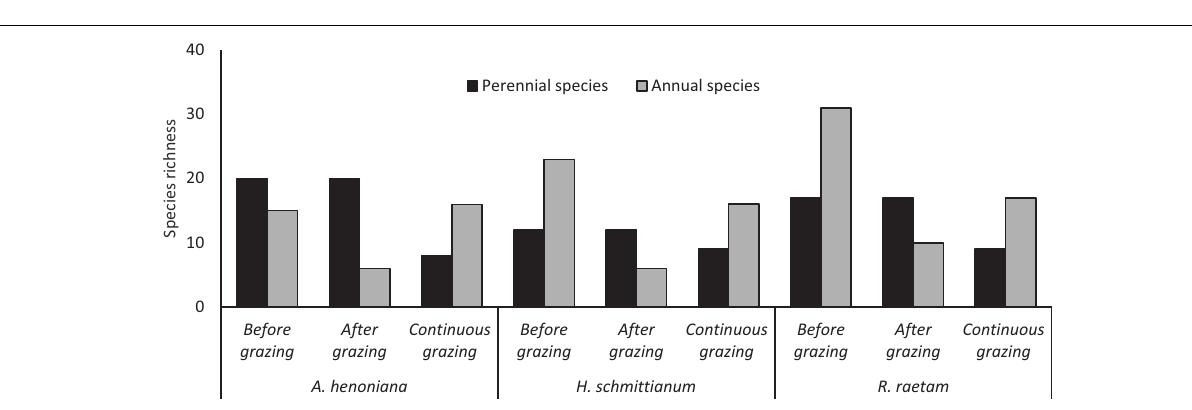
( Supplementary Appendices 1, 2 ). In contrast, high-density grazing for a short period did not affect species richness of perennial species for all plant communities either positively or